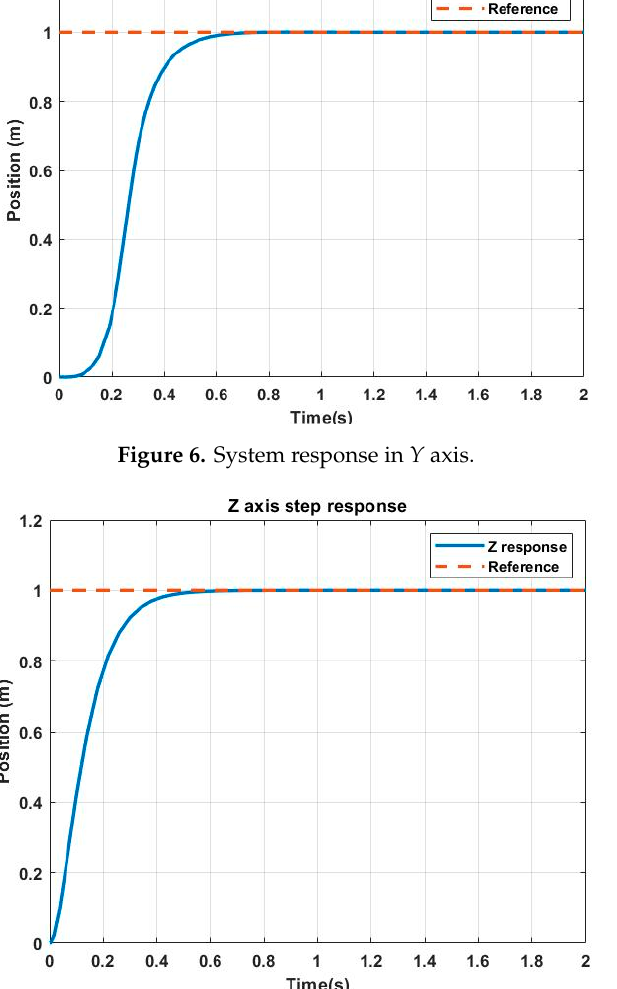
Figure 7. System response in 𝑍 axis.